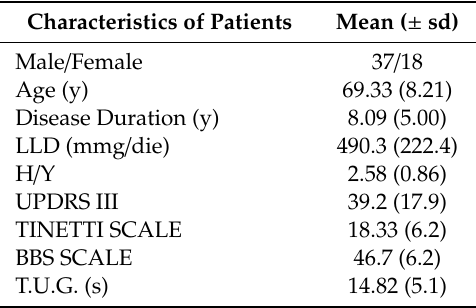
Table 1. Characteristics of patients in T0 (n = 55); PD = Parkinson’s disease; y = years; LEDD = levodopa equivalent daily dose; s =